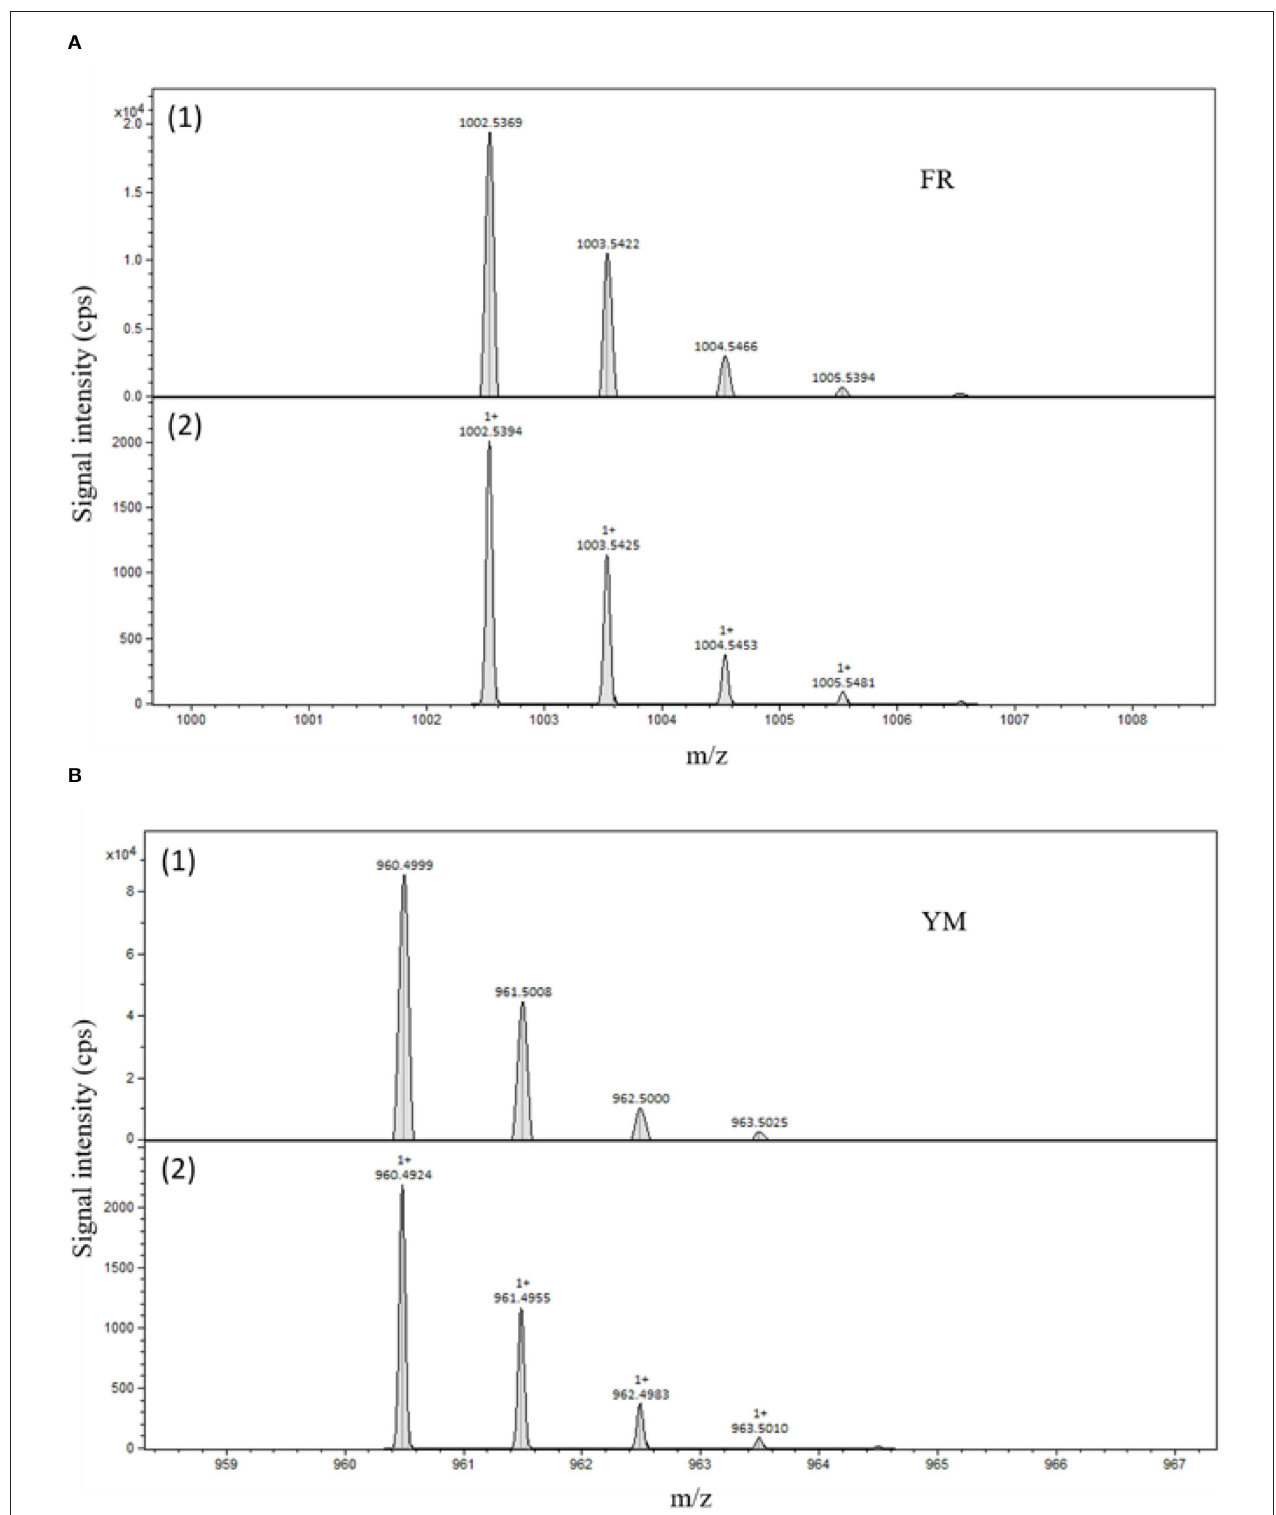
FIGURE 3 | (A) (1) Mass spectrum of FR900359 [x axis: m/z range 999.8–1008.6; y axis: signal intensity in counts per second (cps)]; (A) (2) Calculated mass isotope pattern of FR900359. (B) (1) Top: mass spectrum of YM-254890 [x axis: m/z range 958.4–967.2; y axis: signal intensity in counts per second (cps)]; (B) (2) Calculated mass isotope pattern of